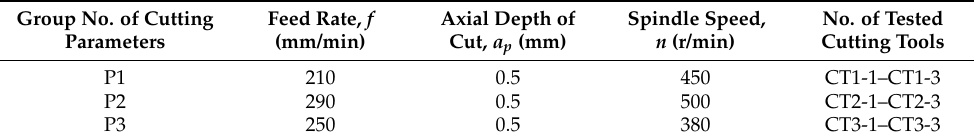
Table 3. Three groups of cutting parameters used in assembly interface machining experiment.